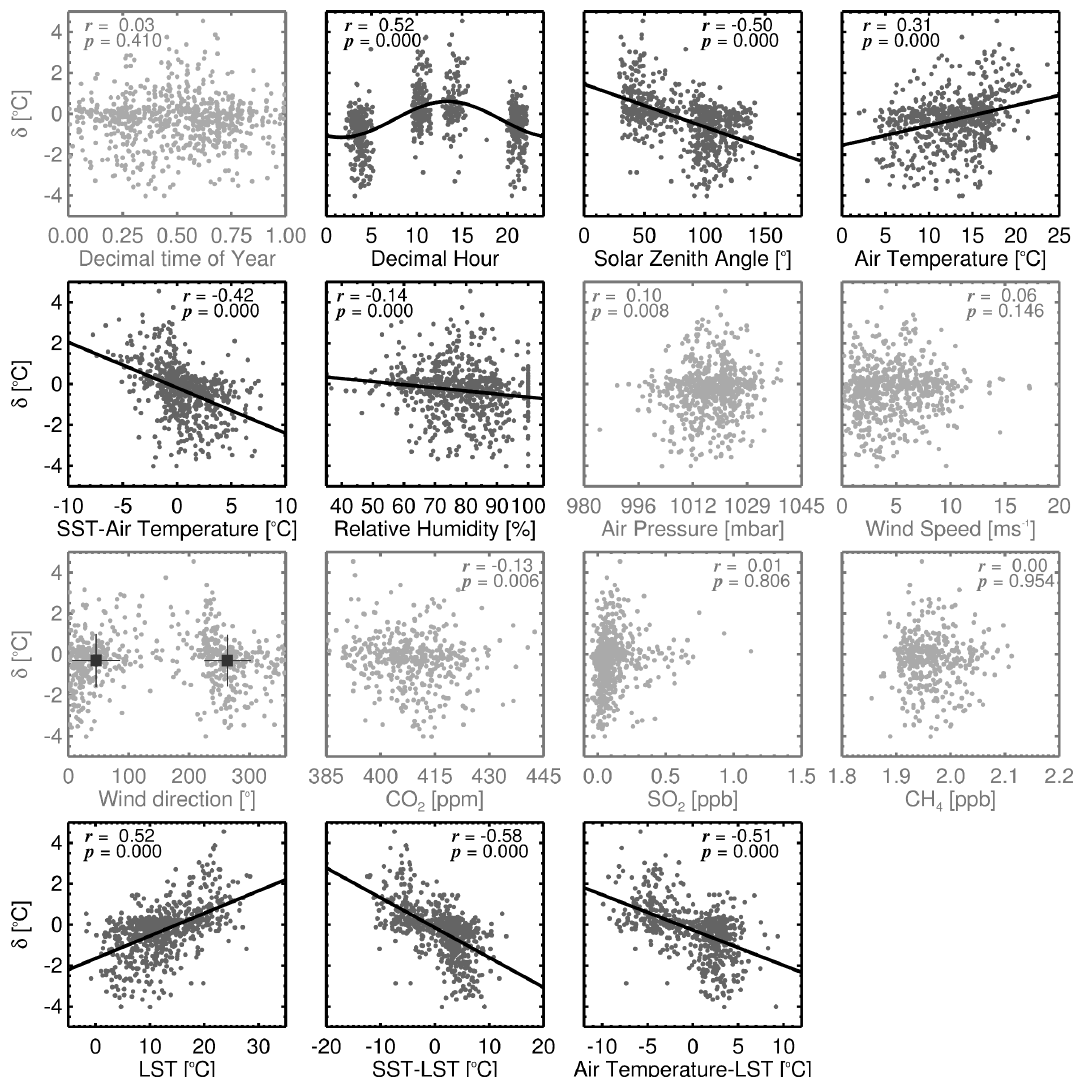
Figure 5. Differences between satellite AVHRR SST N data at the closest pixel to the kelp site and in situ temperature from the kelp site ( δ ) as a function of a variety of variables. Bold plots show where there is a significant relationship (correlation between fit (linear or nonlinear) and data with a p -value < 0.001). For the wind direction, we partitioned data into 0–180 ◦ and 180–360 ◦ and computed mean values and confidence intervals (both overlapped indicating no significant relationship between the two dominate wind directions, southwest and northeast). r is the Pearson correlation coefficient and p is the significance of this